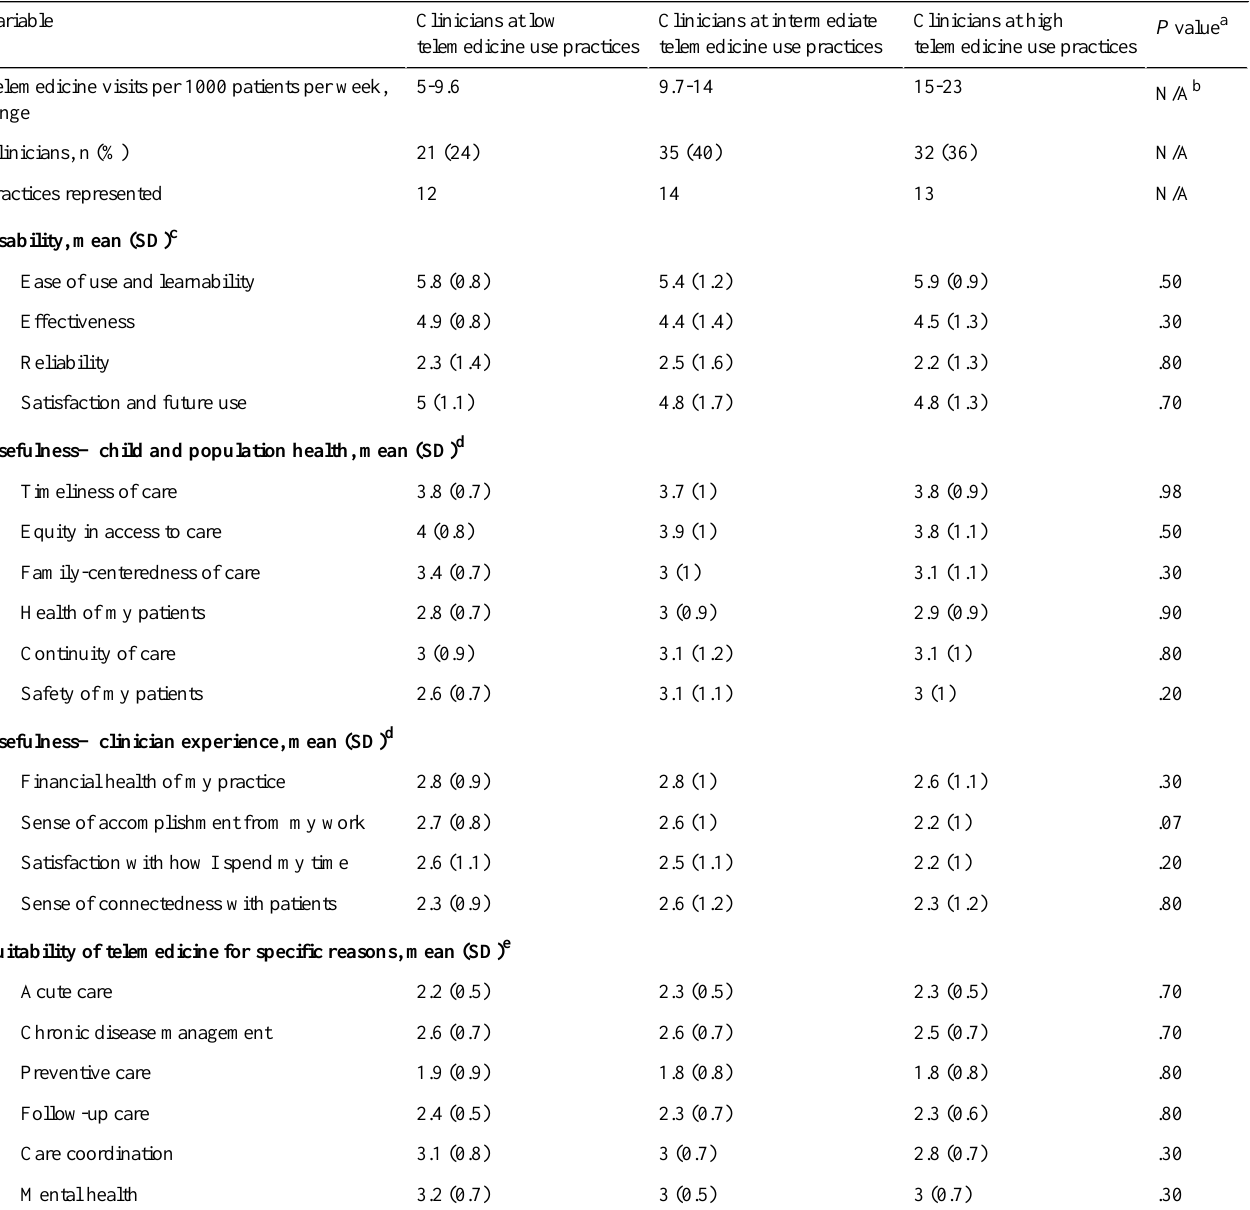
Table 5. Clinician perceptions of usability and usefulness of